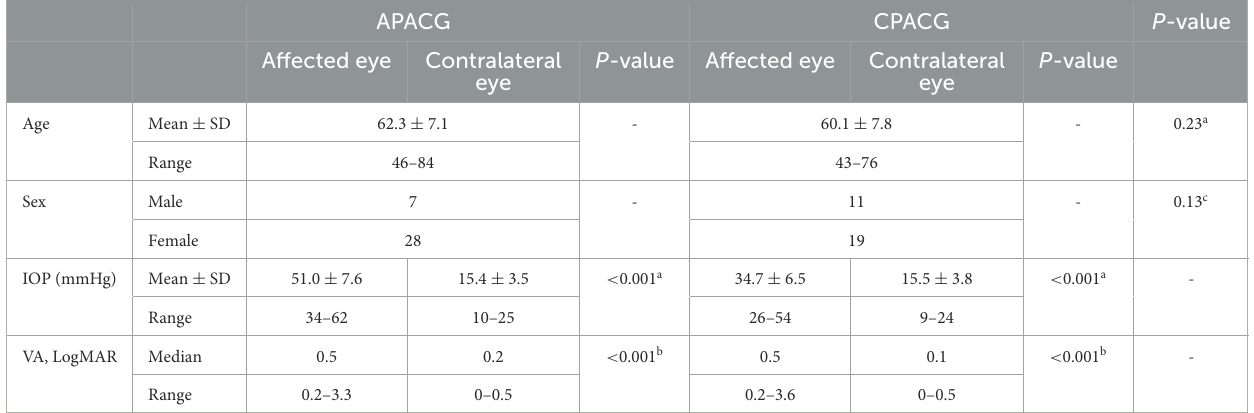
TABLE 1 Demographics and basic clinical data of recruited